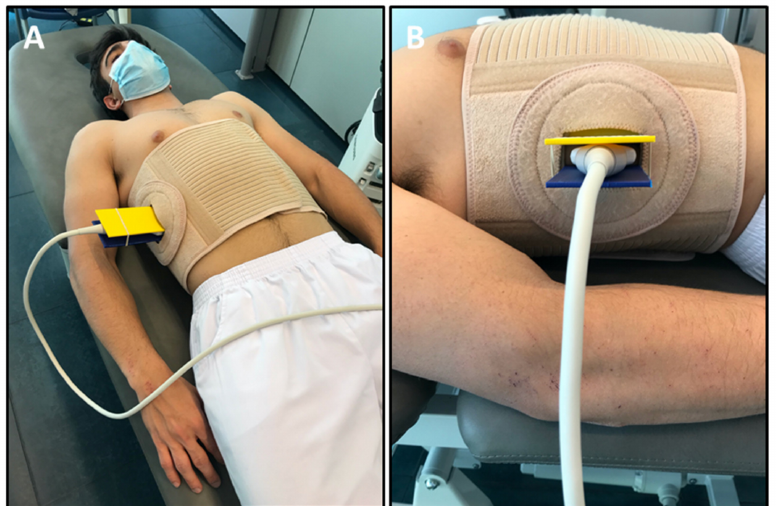
Figure 1. Thoracic orthotic device to measure diaphragm thickness. ( A ) Thoracic orthosis with the holding device to fix the ultrasound (US) probe. ( B ) Support and fixation adapter to place the linear US probe perpendicular to the last intercostal space along the mid-axillary